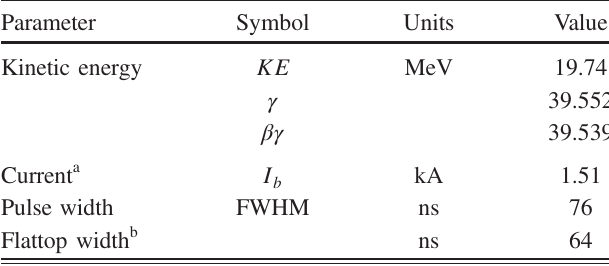
TABLE III. Electron-beam parameters.